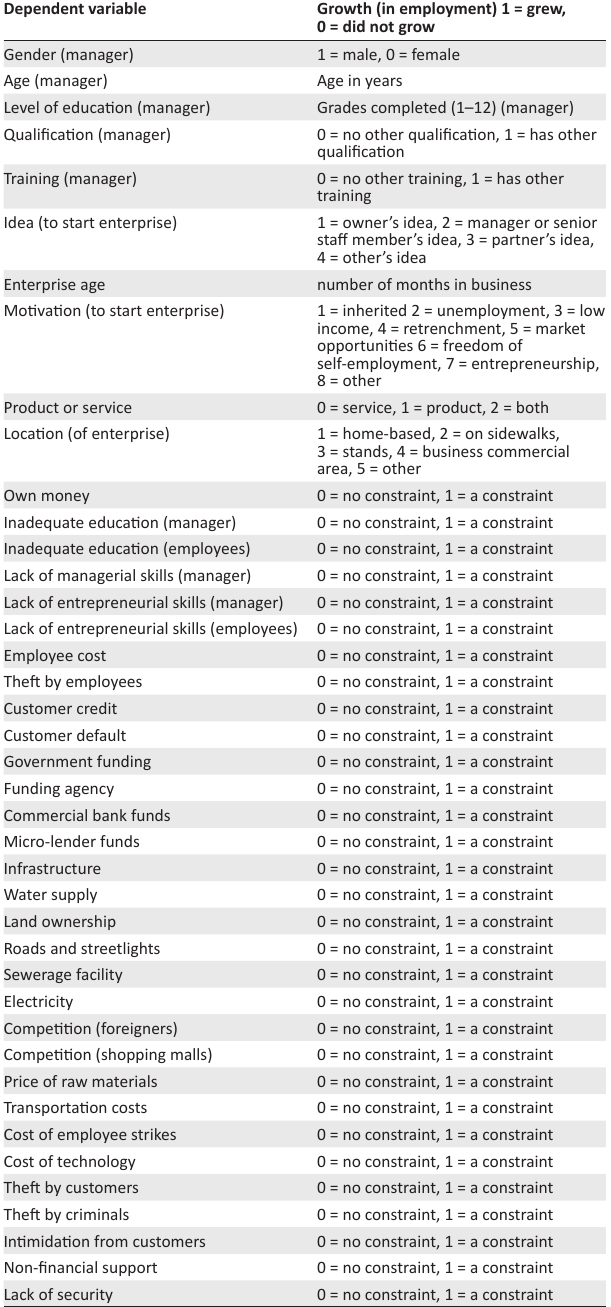
TABLE 1: Variables and measurement